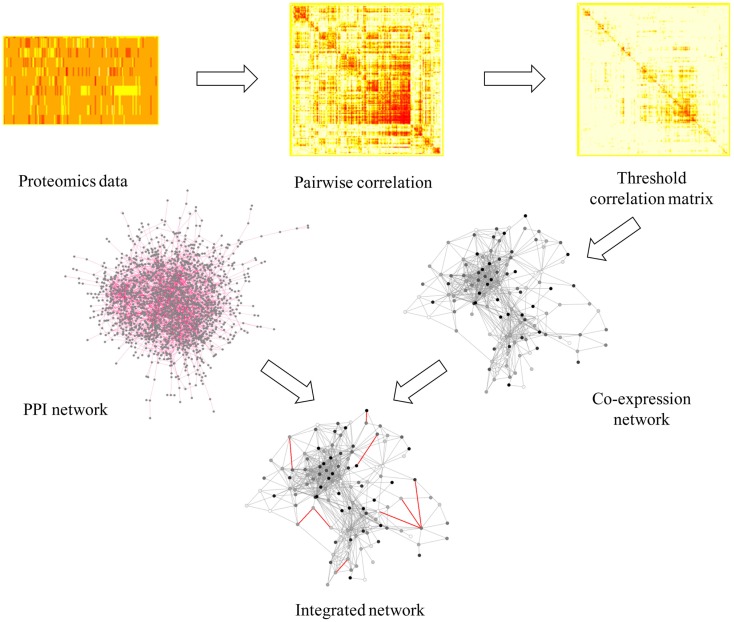
A scheme of workflow to generate protein co-expression network. In integrated network, gray line represents co-expression information and red line represents PPI information.